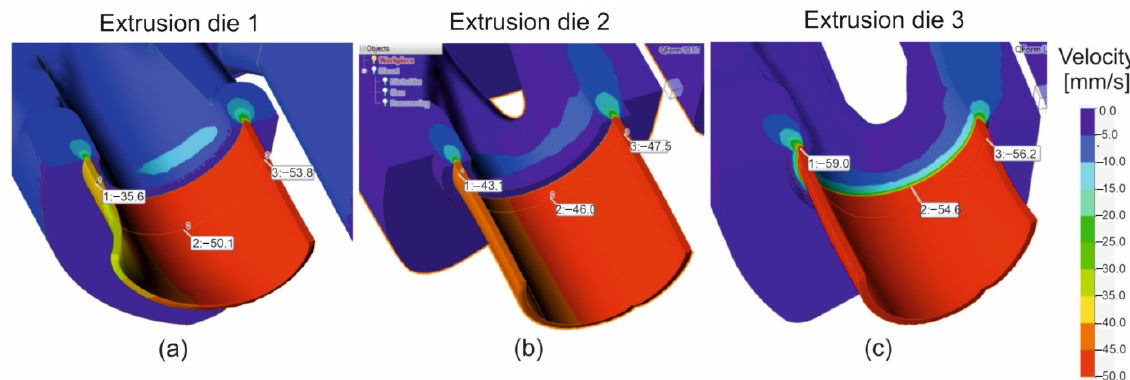
Figure 6. Distribution of metal velocity during extrusion of tubes of Ø50 × 2 mm from 7021 alu- minium alloy through porthole dies of different geometry—die 1 ( a ), die 2 ( b ) and die 3 ( c